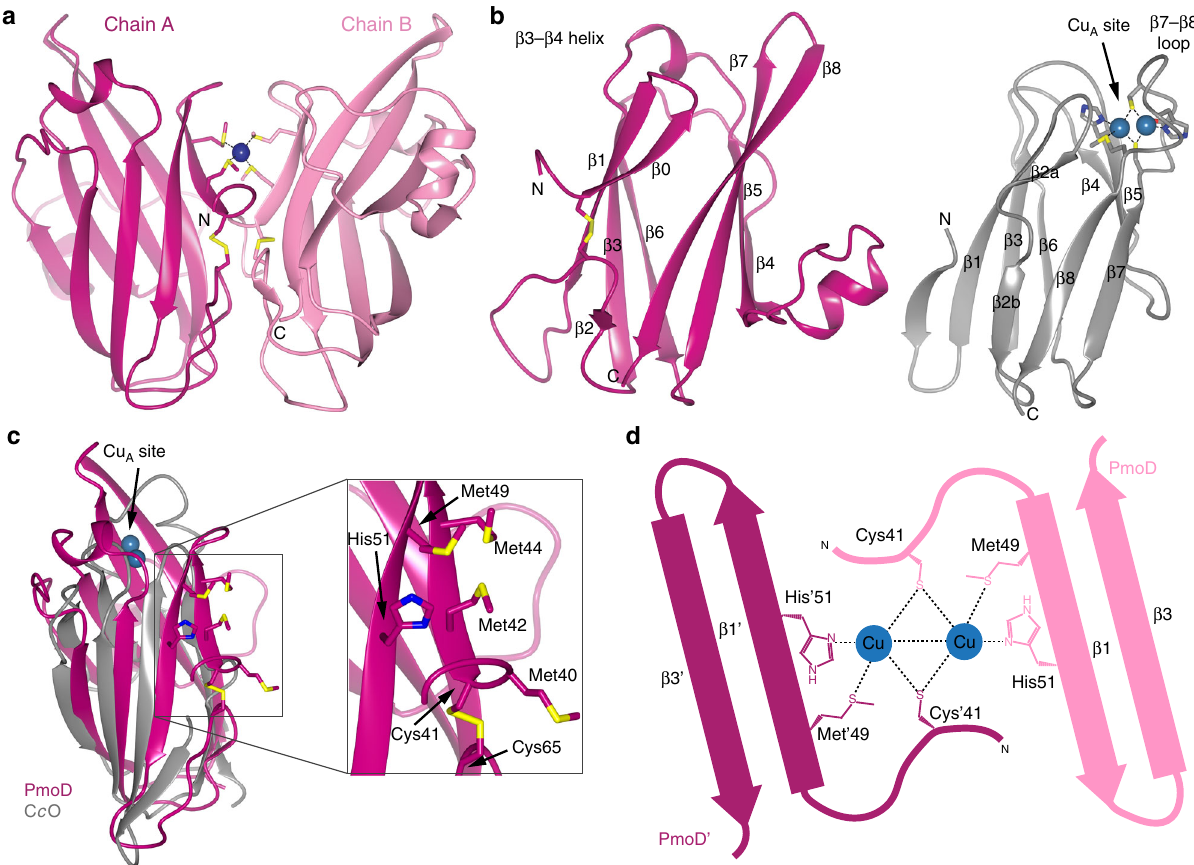
Fig. 2 Structural comparison of PmoD Met49242_1452 to Cu A -containing domains. a Crystal structure of PmoD Met49242_1452 periplasmic domain. The asymmetric unit of the crystal is shown as a ribbon diagram, with chain A in magenta and chain B in pink. The copper ion is depicted as a blue sphere and the coordinating residues as well as the two invariant cysteines are shown in stick format. b Comparison of PmoD Met49242_1452 structure (left; magenta) to the Cu A -containing domain of T. thermophilus C c O (PDB: 2CUA). Secondary structure elements are labeled, and the Cu A site in C c O is indicated with Cu ions shown as spheres and coordinating ligands in stick format. c Superposition of PmoD Met49242_1452 periplasmic domain (magenta) with C c O (gray) colored as in ( b ). The box indicates the region containing the PmoD Met49242_1452 candidate metal binding ligands, and the inset shows a close-up of the same, shown in stick format. d Model depicting how PmoD Met49242_1452 can form a Cu A -like site as a dimer. The two molecules are shown as pink and magenta cartoons, with the residues identi fi ed as ligands